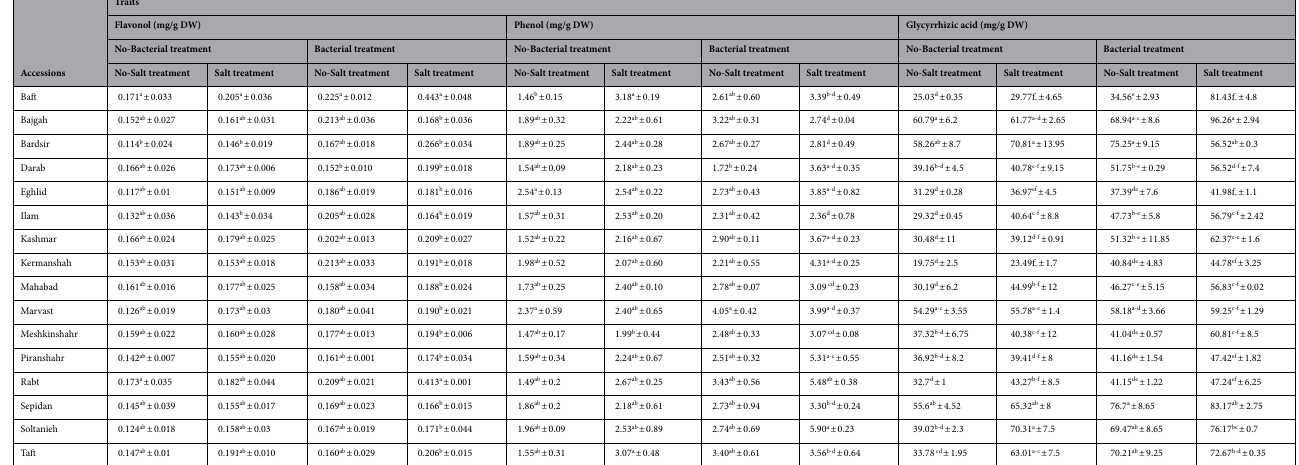
Table 2. Effect of Azotobacter and salinity stress interactions on measured metabolites of 16 Iranian Licorice accessions. According to the analysis of variance, the triple effects of Azotobacter , salinity, and accessions showed a significant difference, the slice method was used for mean comparisons. Mean values with the same letters within a column are not significantly different ( p ≤ 0.05), Tukey test. Means ± standard error (SE).